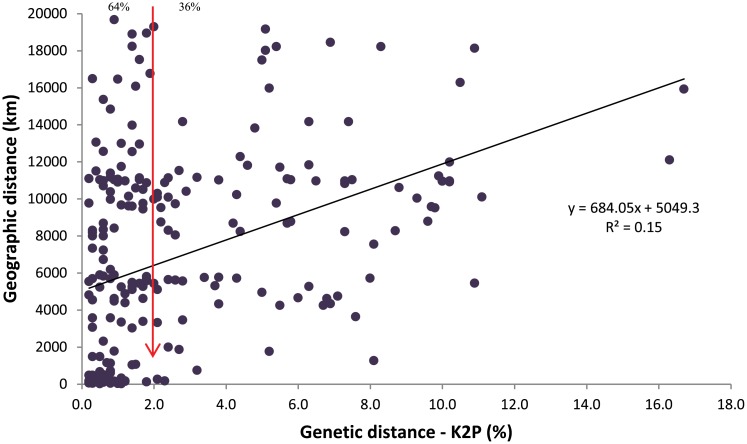
Intraspecific variation (K2P) at the COI gene against geographical extent (km) of moth species from Pakistan and their conspecifics from other regions.Vertical downward arrow (red) indicates the percentage of species with less or more than 2% divergence across their range.